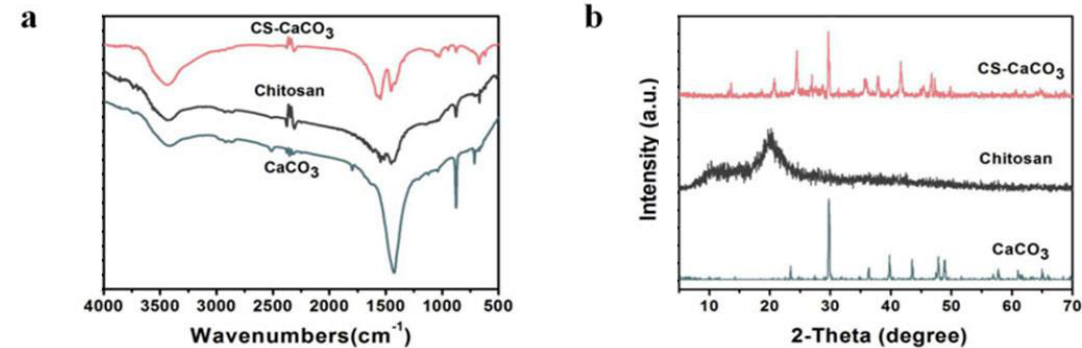
Figure 3. ( a ) XRD pattern of CaCO 3 , CS and CS–CaCO 3 ; and ( b ) FTIR spectra of CaCO 3 , CS and CS–CaCO 3 . The CaCO 3 , chitosan, and CS–CaCO 3 were further characterized by XRD analysis. The XRD peaks obtained for the CaCO 3 particles matched with the XRD peaks of CaCO 3 that corresponded to calcite (The Inorganic Crystal Structure Database (ICSD) no. 158257) [28]. It is evident that native Chitosan had characteristic broad peaks at 21.08, which are typical of a chitosan structure. In the XRD spectra of CS–CaCO3, the characteristic peak of CaCO 3 at 2 θ of 23.44 ◦ , 29.76 ◦ , 36.34 ◦ , 39.8 ◦ , 43.5 ◦ , 47.84 ◦ , 48.94 ◦ was observed (Figure 3b). This further confirmed the presence of CaCO 3 in the composite materials. The crystallinity of CaCO 3 was higher than CS–CaCO3. There was almost no difference in crystallinity between CaCO 3 and CS–CaCO 3 . The result indicated that complexation did not